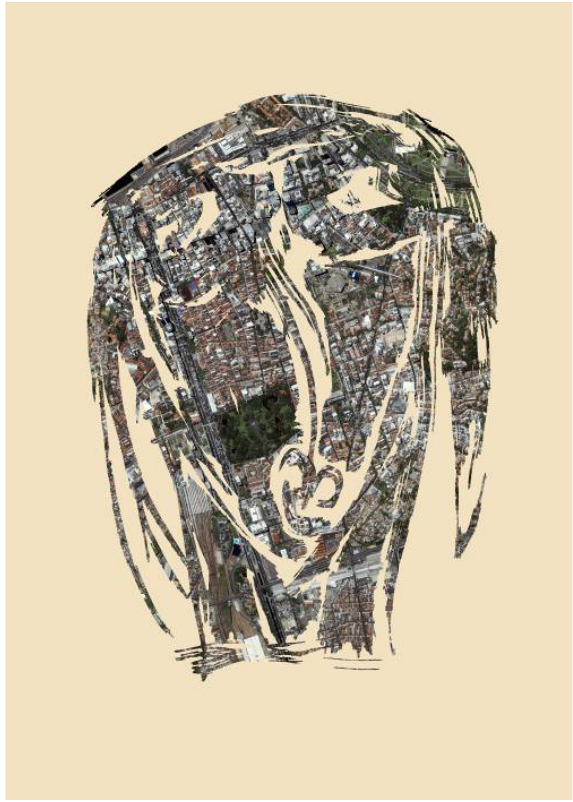
Figure 8 Tamer Assem – Sarajevo Woman – Digital Print – 70x50cm – (2017)